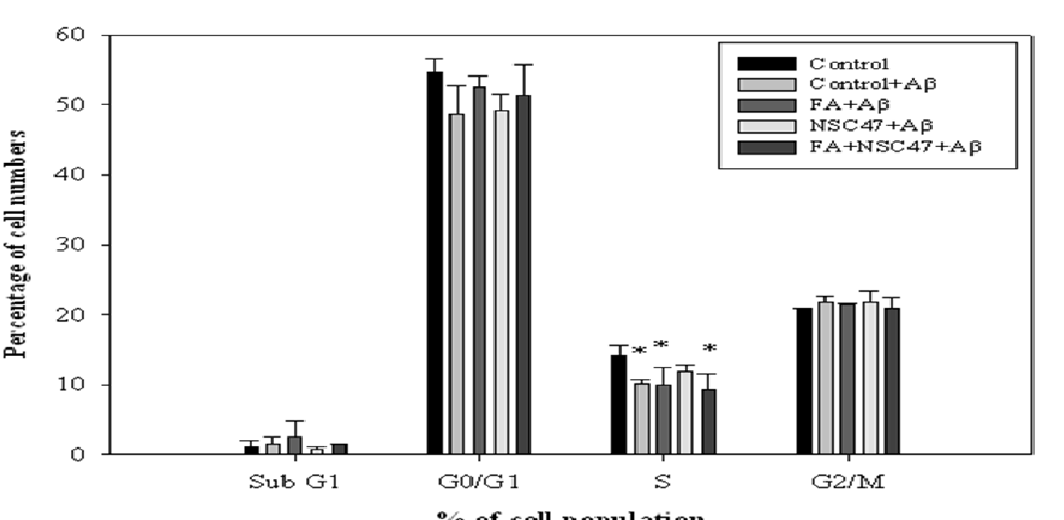
Figure 5. Effects of folic acid (FA) or/and NSC47 on the cell cycle distribution of β - amyloid (A β )-treated C13NJ